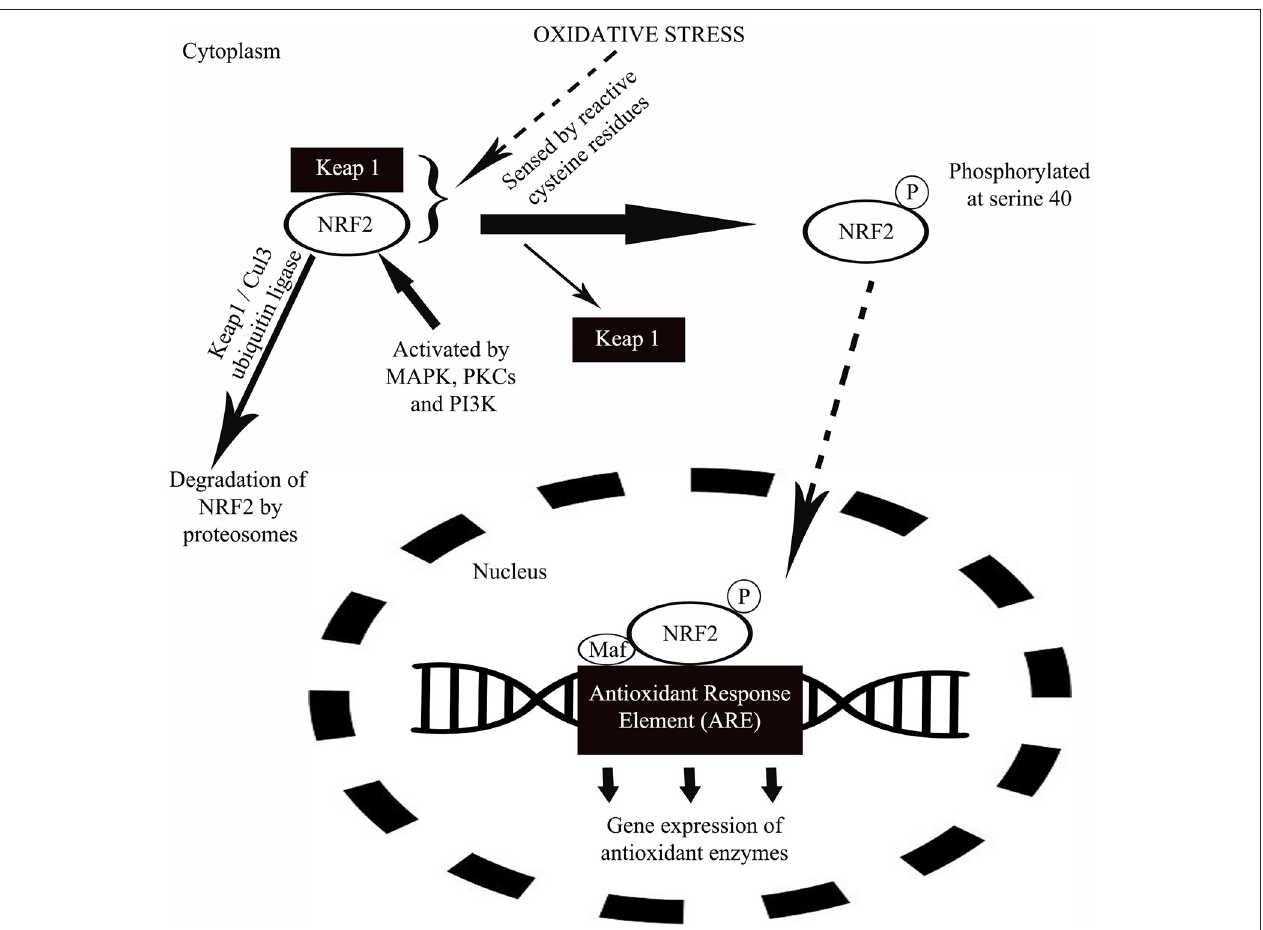
FIGURE 3 | A schematic diagram showing the mechanism of NRF2 in protection against oxidative stress. Under normal condition, a protein called Keap1 suppresses the activity of NRF2 by physically binding to NRF2 and at the same time anchored to cytoplasm. Following a period of inactivity, NRF2 is degraded by proteasomes. During oxidative stress, oxidants will be sensed by the Keap1/NRF2 complex via reactive cysteine residues in Keap1. Upon oxidant sensing, NRF2 undergoes phosphorylation at serine40 releasing Keap1 from the complex. This is followed by the translocation of NRF2 to nucleus where the protein forms a heterodimer with small transcription factor Maf and binds to antioxidant response enzyme (ARE) of numerous antioxidant gene promoter regions to initiate their transcription in response to oxidative